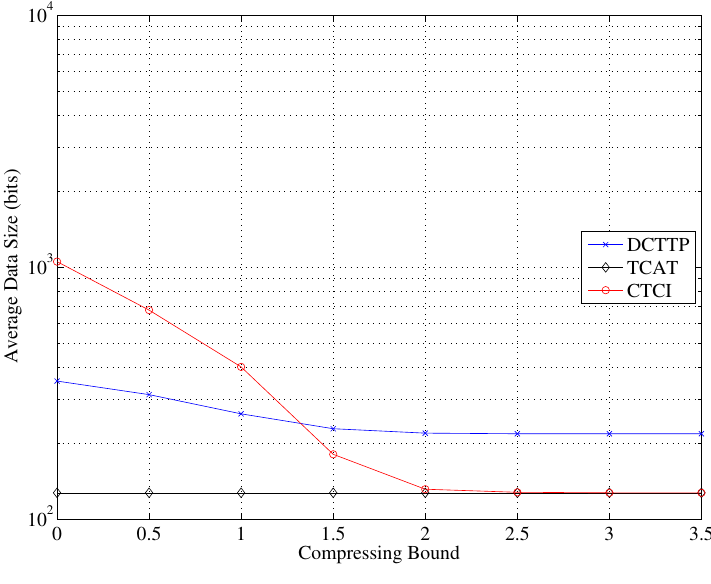
Figure 25. Impact of the compressing bound on the average data size.